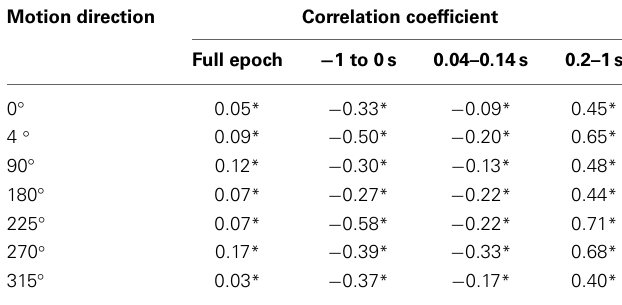
Table 1 | Correlation of LAIS and local VSD activity. Motion